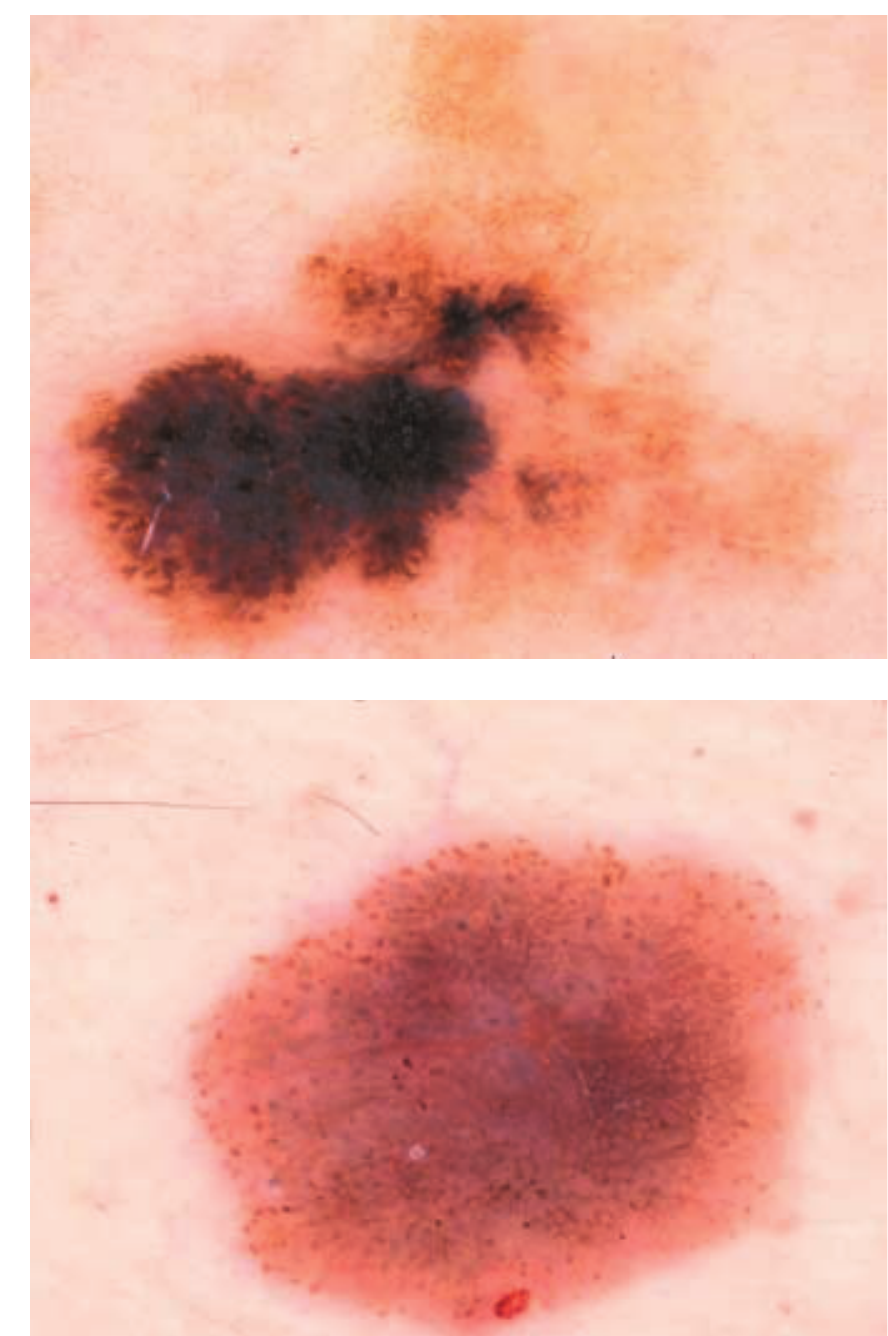
Figure 3 Dermoscopy image of the melanoma seen in figure 1.